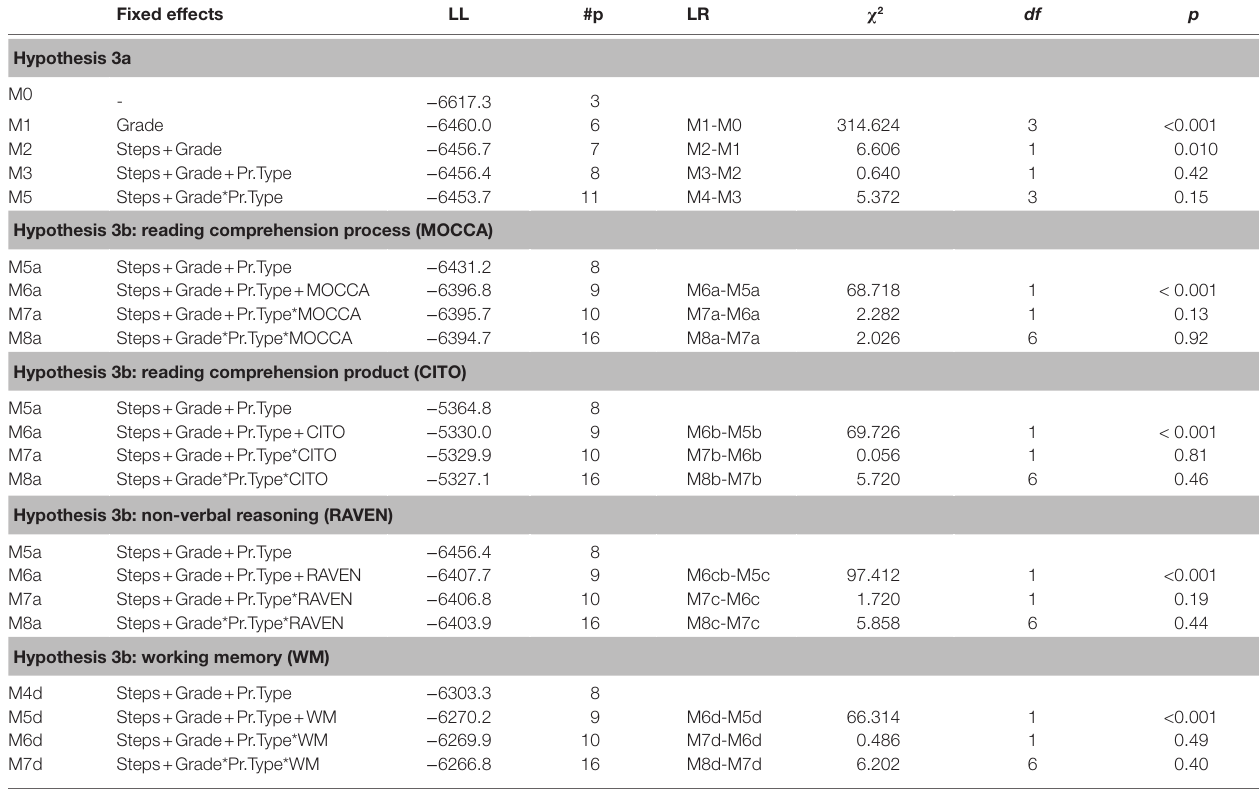
TABLE 6 | Statistical tests for research question 3: non-standard versus standard word problems. Fixed